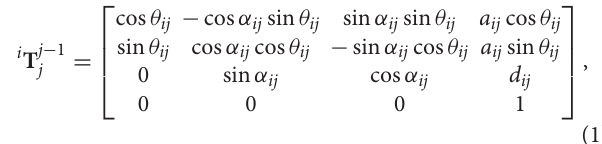
Where i 1 , 2 , , 6 is the number of six = ···